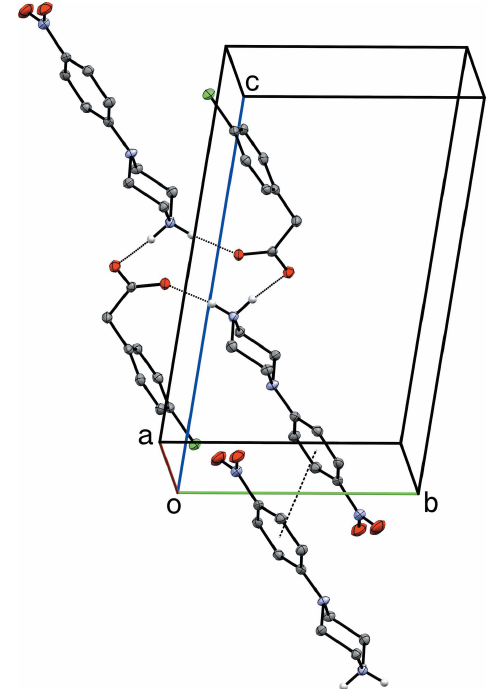
Figure 8 A partial packing plot of III showing a hydrogen-bonded (dotted lines) R 4 (12) ring motif and a (cid:2) – (cid:2) interaction (dashed line) between inversion- 4 related cations. Hydrogen atoms not involved in hydrogen bonds are